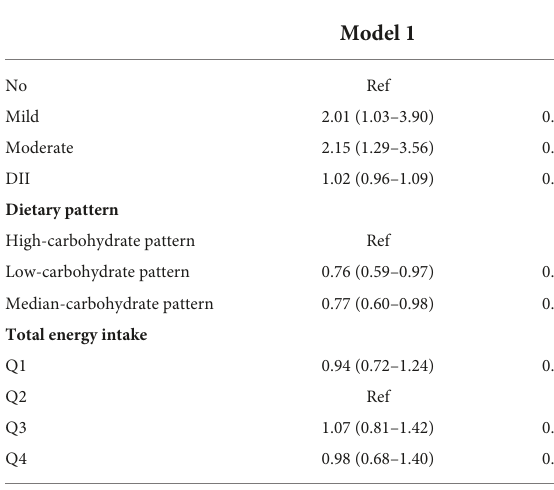
TABLE 2 Hazard ratio of outcomes by adjusted analysis.